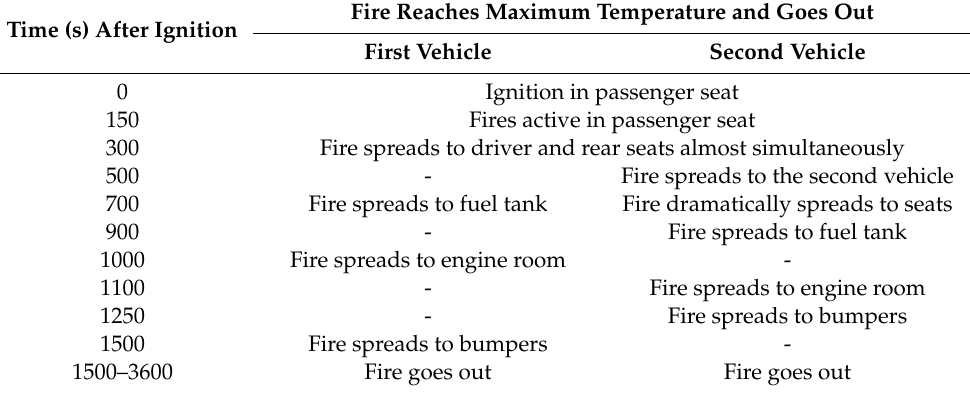
Figure 6. Major fire-spreading flow-chart. Table 2. Detailed information on the fire-spreading characteristics and special events as a function of time.